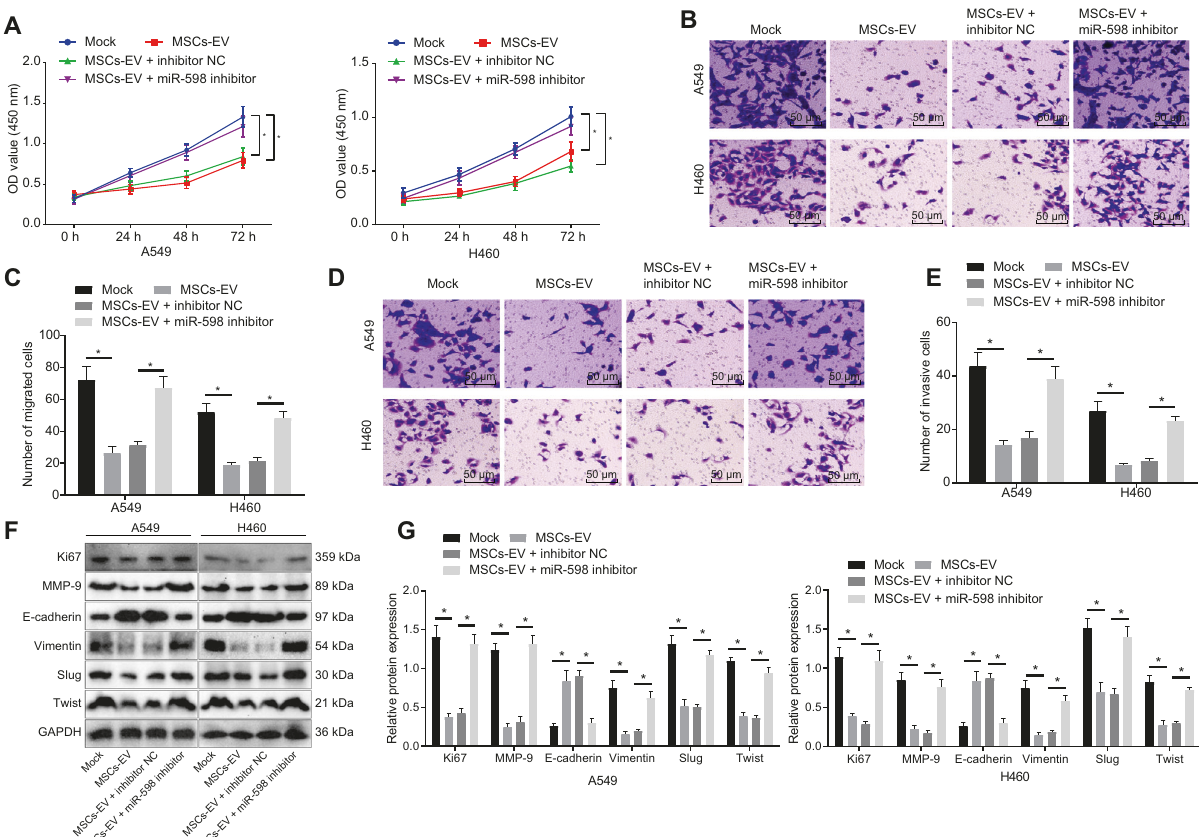
Fig. 3 Effects of EVs-derived miR-598 on the proliferation, migration, and invasion abilities of NSCLC cells. A Proliferative ability of A549 and H460 cells detected by CCK-8 assay. B Migrated ability of A549 and H460 cells detected by Transwell assay. C Statistical analysis of ( B ). D Invasive ability of A549 and H460 cells detected by Transwell assay. E Statistical analysis of ( D ). F Protein bands of Ki67, E-cadherin, Vimentin, MMP-9, Slug, and Twist by Western blot analysis. G Protein levels of Ki67, E-cadherin, Vimentin, MMP-9, Slug, and Twist by Western blot analysis (statistical analysis of ( F )). * p < 0.05 between two groups. Data between two groups were compared by an unpaired t test. Da t a among multiple groups were compared by ANOVA with Tukey ’ s post hoc test. Comparisons among groups at different time points were performed using repeated measures ANOVA with Bonferroni ’ s post hoc test. Cell experiments were repeated three times. downstream regulatory mechanism of miR-598, we predicted the MSCs-EVs + miR-598 inhibitor-treated mice was suppressed when target genes of miR-598 based on TargetScan, miRDB, miRWalk, compared to that of the MSCs-EVs + inhibitor NC-treated mice mirDIP, and DIANA databases. As shown in Fig. 5A, we obtained (Fig. 4D). Western blot analysis revealed that the Ki67 protein level 665, 20, 8531, 273, and 252 target genes from the aforementioned in the tumors of nude mice was reduced by MSCs-EV treatment, online prediction databases respectively Venn analysis indicated which was promoted by additional miR-598 inhibitor treatment six intersected genes (SLC6A13, MYH8, SLC35D3, PANK1, THBS2, (Fig. 4H). In addition, we established a pulmonary metastasis and MN1), which were regarded as the target genes of miR-598. model and extracted the lungs for examination after various Differential analysis of the NSCLC gene datasets screened 634, treatments. MSCs-EV treatment reduced the number and size of 250, and 961 differential genes from GSE19188, GSE33532, and metastatic nodules in the lungs, which were increased by GSE101929 datasets, respectively. After intersection of these sets additional miR-598 inhibitor treatment (Fig. 4E – G). Then, as of differentially expressed genes, we isolated six miR-598 target Western blot analysis detected, the protein levels of Vimentin genes, and fi nally obtained THBS2 gene by Venn analysis (Fig. 5B). and MMP-9 were reduced in the MSCs-EVs-treated mice relative to The fi ndings for expression of THBS2 in GSE19188, GSE33532, and untreated mice, while the expression of E-cadherin was enhanced; GSE101929 datasets showed thatTHBS2 had abnormally highly these effects were reversed by miR-598 inhibitor treatment expression in NSCLC (Fig. 5C), leading us to speculate that the (Fig. 4H). Meanwhile, similar results were obtained in considering differential expression of THBS2 may be regulated by miR-598. the roles of MSCs-EVs secreted miR-598 on the tumorigenesis and Besides, as suggested by Kaplan-Meier survival analysis, NSCLC metastasis of H460 cells in nude mice, as reported in Supplemen- patients with high expression of THBS2 presented a worse tary Fig. 2. To summarize, these in vivo experiments con fi rmed prognosis (Fig. 5D). RT-qPCR and Western blot analysis results that EVs-carried miR-598 inhibited the tumor growth and showed that, when compared with the adjacent normal tissues, metastasis of NSCLC. THBS2 was highly expressed in the tumor tissues of NSCLC patients (Fig. 5E). THBS2 is a direct target gene of miR-598 The speci fi c binding sites between miR-598 and THBS2 were The above experiments revealed that EVs-encapsulated miR-598 predicted by Targetscan (Fig. 5F). Dual luciferase report assay was inhibited the proliferation, migration, and invasion capabilities of then utilized to verify the targeting relationship between miR-598 NSCLC cells, in vitro and in vivo. To further investigate the Cell Death Discovery (2023)